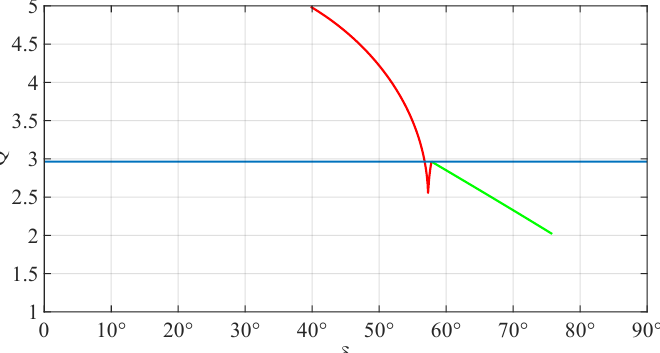
Figure 14. Drive force under transformable state C 1 and C 2 Q (5 mm) (Blue: wheel state; Red: C 1 ; Green: C 2 ).